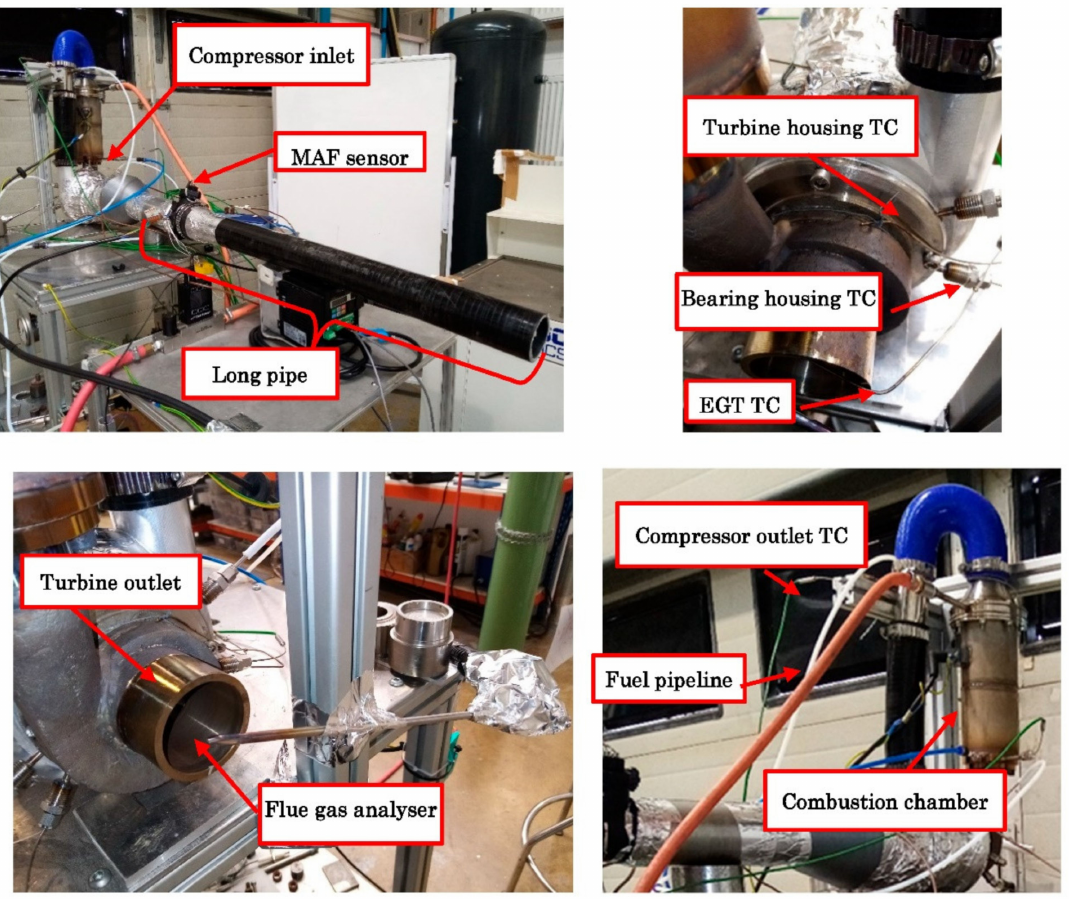
Figure 15. Complete views of the test bench